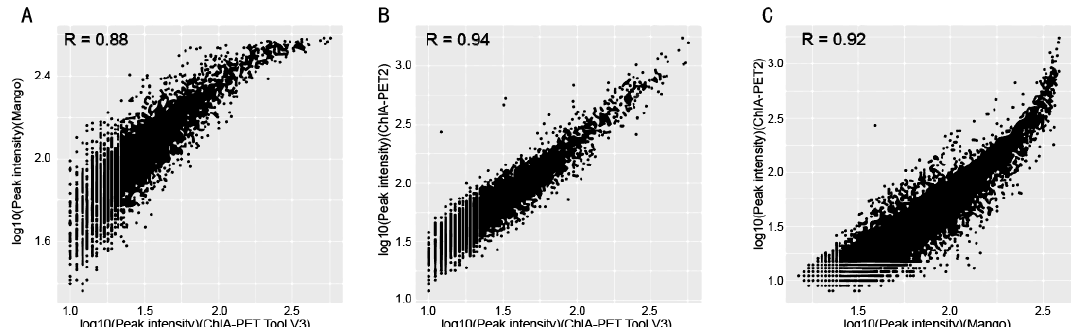
Figure 11. Scatter plots of peak intensity between different tools from human K562 cells. ( A ) Peak intensity between ChIA-PET Tool V3 and Mango. ( B ) Peak intensity between ChIA-PET Tool V3 and ChIA-PET2. ( C ) Peak intensity between Mango and ChIA-PET2.